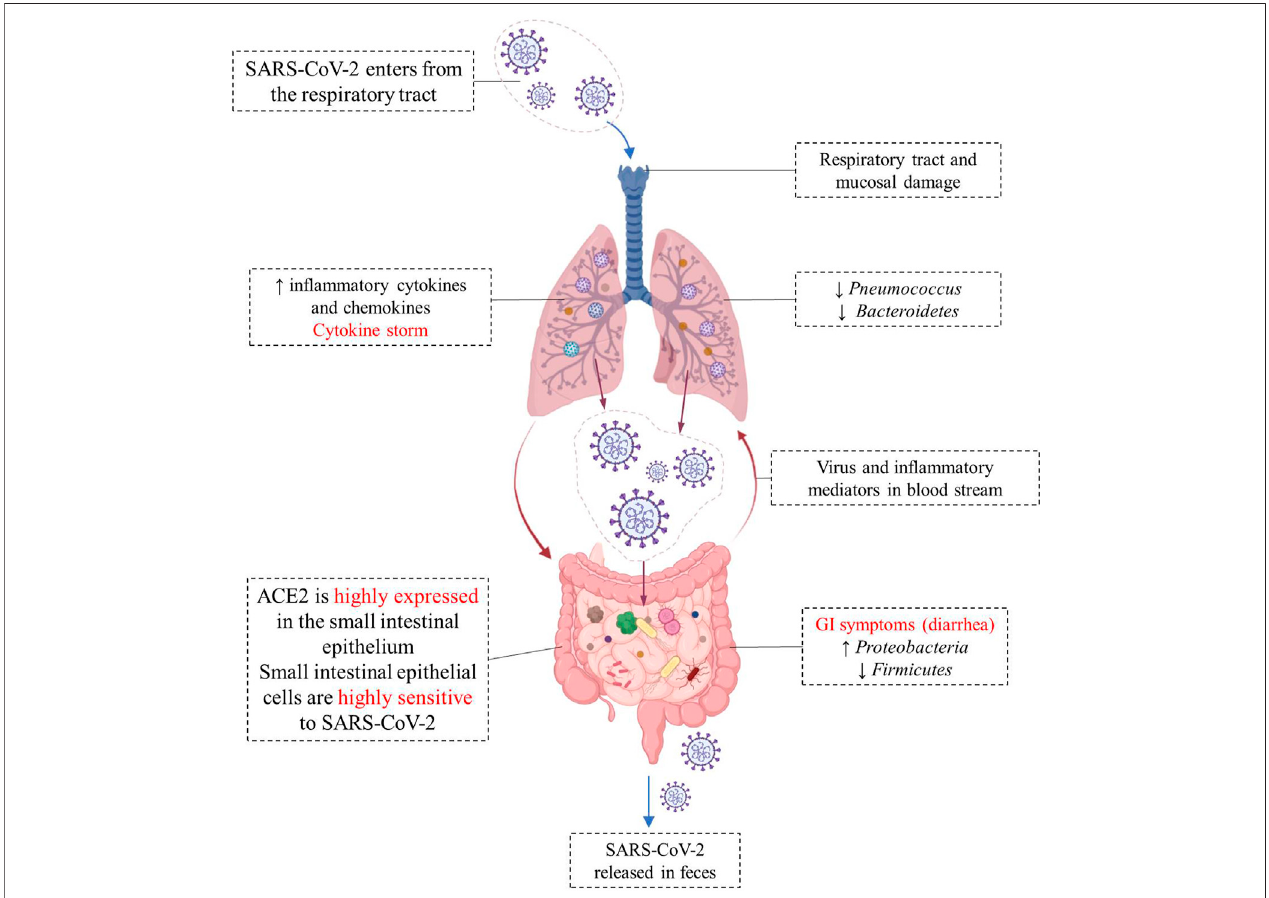
FIGURE1| Differentchangesinthe “ gut-lungaxis ” afterinfectionwithCOVID-19.Respiratorytractinfectionincreasestheproductionofcytokinesandchemokines and causes changes in the microbial composition of micro fl ora. Changes in the lung microbiome may cause speci fi c host immune responses. The high expression of ACE2 in the small intestine makes small intestinal epithelial cells highly sensitive to SARS-CoV-2, and the viral infection leads to intestinal malabsorption, secretion imbalance, and diarrhea. SARS-CoV-2 RNA has been detected in fecal sample of COVID-19 patients.